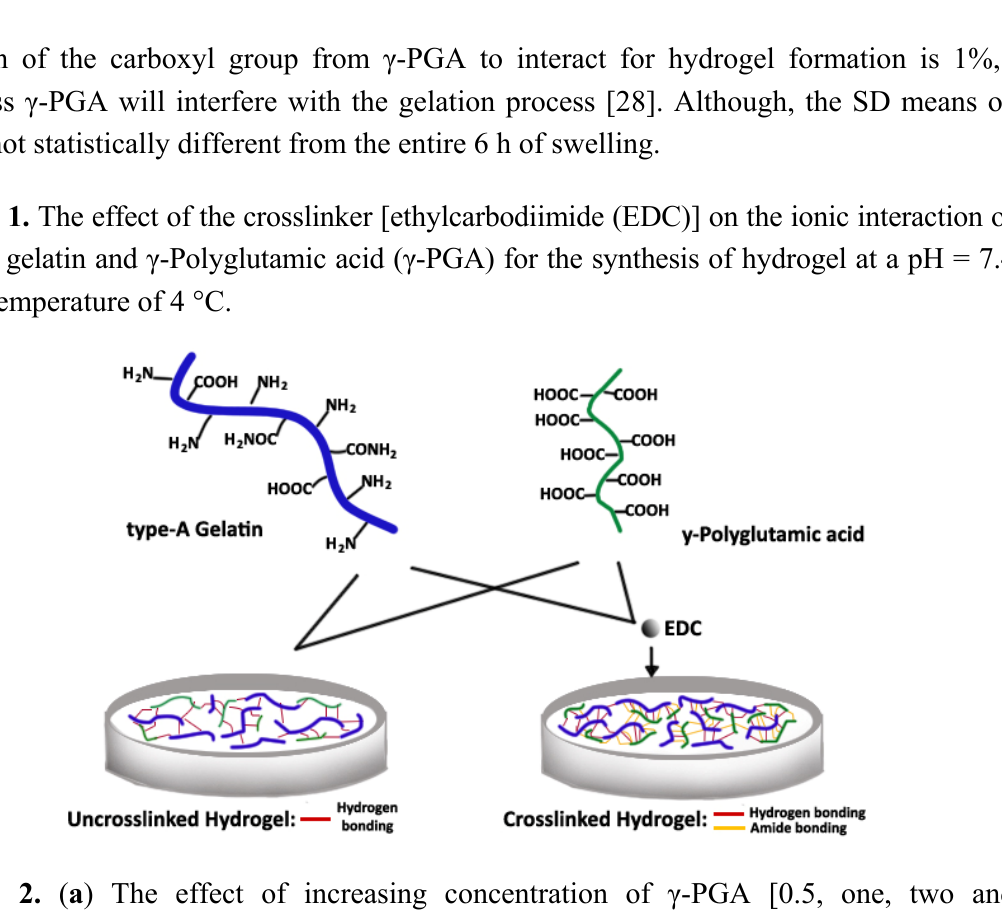
Figure 2. ( a ) The effect of increasing concentration of γ -PGA [0.5, one, two and 4 w/v% (g/mL)] on the swelling degree (SD) of hydrogel at a constant formulation of 10 w/v% gelatin and of 1.3 mg/mL EDC, swelled in phosphate buffered saline (PBS) (pH = 7.4) for 6 h; ( b ) The effect of increasing concentration of gelatin [eight, 10 and 12 w/v% (g/mL)] on the swelling degree (SD) of hydrogel at a constant formulation